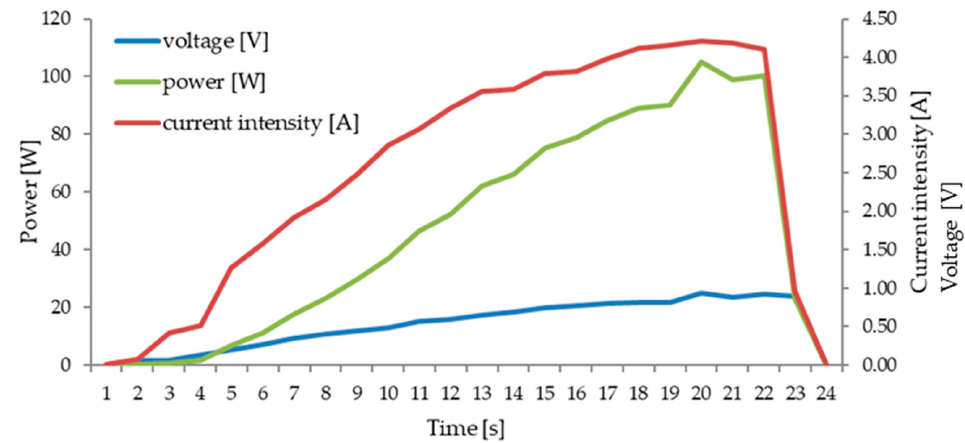
Figure 7. Time dependence of current, voltage current, and power generated by the hybrid turbo- charger (experimental result).